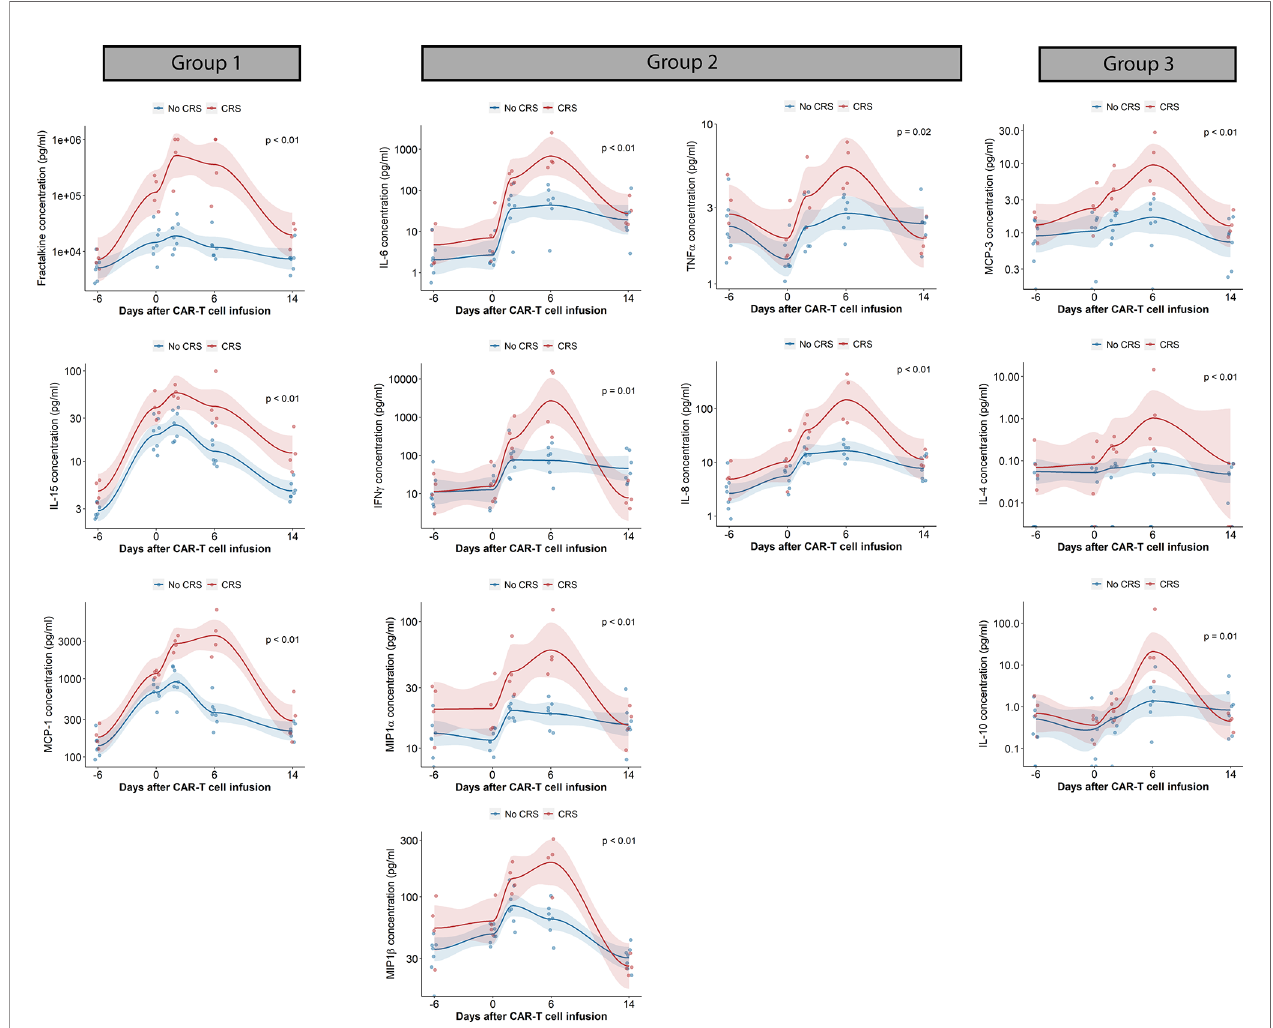
FIGURE 3 | Cytokine changes in CAR-T cell patients treated with prophylactic tocilizumab (n = 13). Scatterplots of cytokine concentrations measured by electrochemiluminescence. Trends generated by locally estimated scatterplot smoothing (LOESS). AUC of cytokine concentration (pg/mL x days) compared with Wilcoxon rank sum test. Blue dots and lines represent patients without CRS, red dots and lines represents patients with CRS. AUC, Area under the curve; CRS, cytokine release syndrome; INF g , interferon gamma; IL, interleukin; MCP, monocyte chemoattractant protein; MIP, Macrophage in fl ammatory protein; TNF a , tumor necrosis factor alpha. A. Boxplot of time – based changes in cytokine concentrations with statistically signi fi cant differences between patients with CRS (red) and without CRS (blue). Comparisons done with Wilcoxon